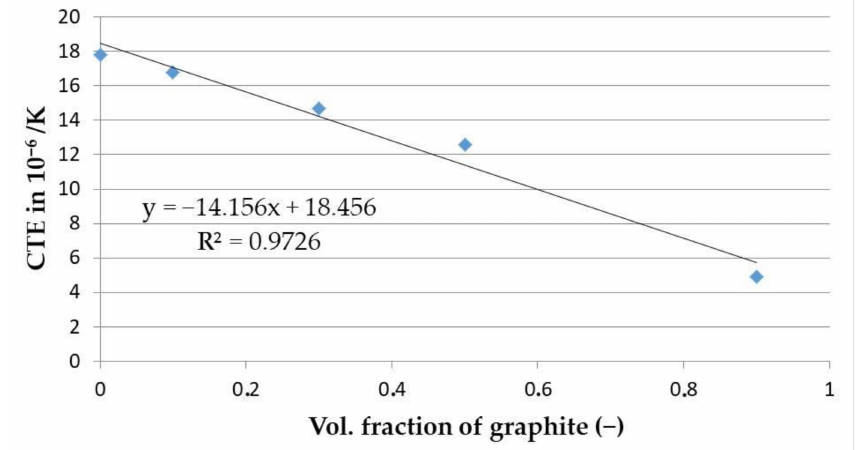
Figure 7. The CTE values of the Cu–graphite composites fitted by a straight